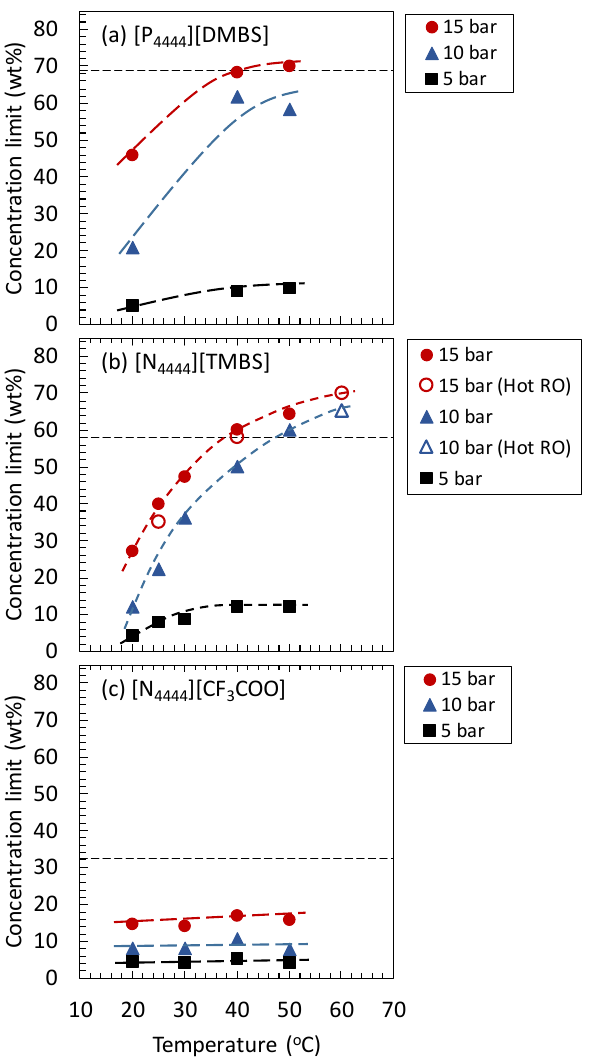
Figure 4. Effect of temperature on upper concentration limits of each IL-DS. ( a ) [P 4444 ][DMBS], ( b ) [N 4444 ][TMBS], and ( c ) [N 4444 ][CF 3 COO]. The solid symbols correspond to results predicted from the relationship between osmotic pressure and IL concentration shown in Figure 3. The open symbols correspond to experimentally determined concentration limits of [N 4444 ][TMBS] for RO under various pressure and temperature